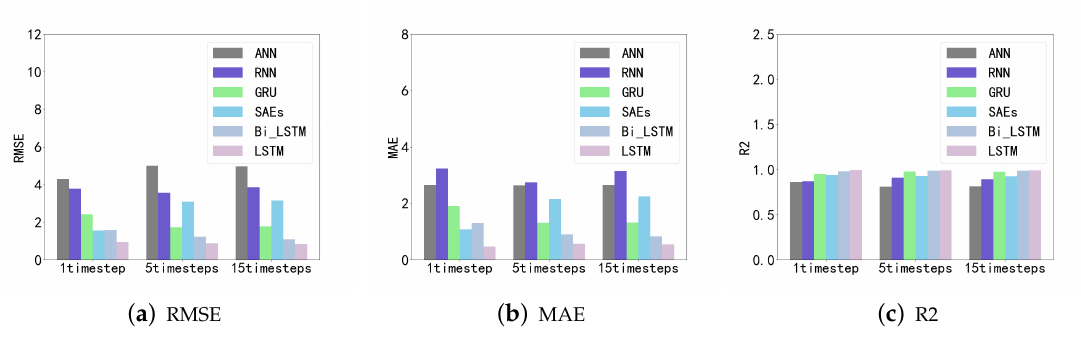
Figure 10. RMSE, MAE and R2 comparison